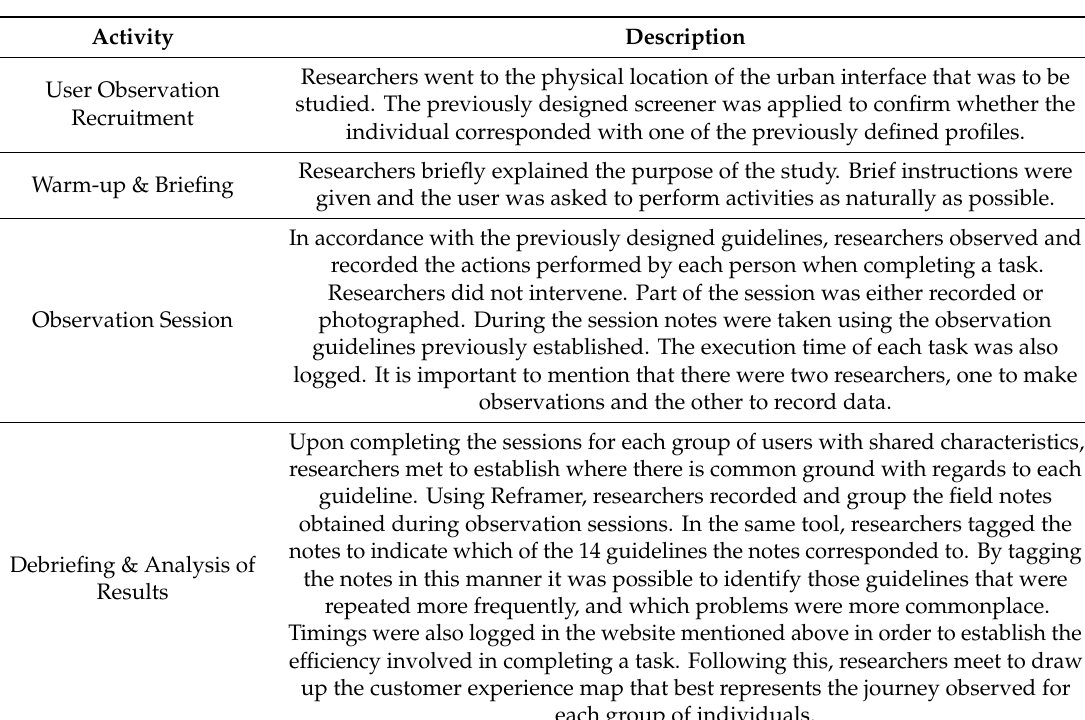
Figure 13. Screenshot of the web-based system used to capture quantitative data and evaluate the 14 guidelines for an urban interface. Table 5. Procedure and activities performed for each